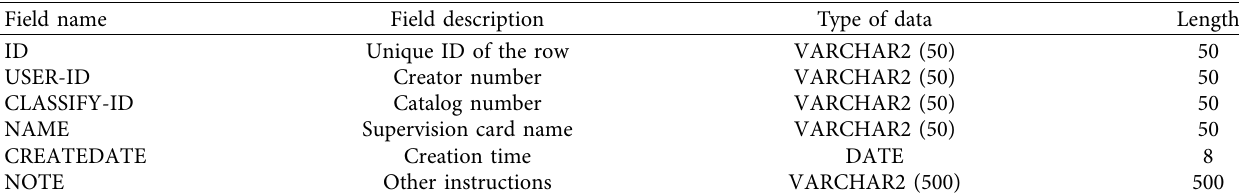
Table 3: Monitoring record data